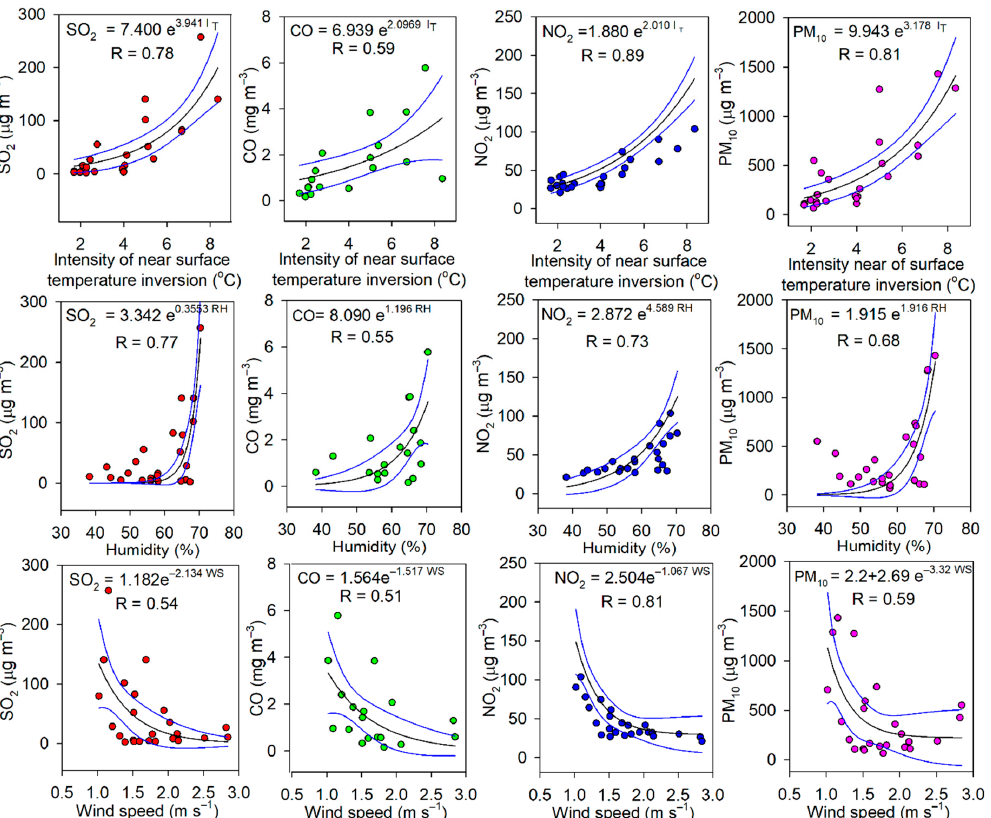
Figure 14. Correlations between monthly average air pollutants and meteorological parameters (West crossroad station) at 00:00 (UTC+08). The black line is the regression line, while the blue lines are the 95% confidence band.